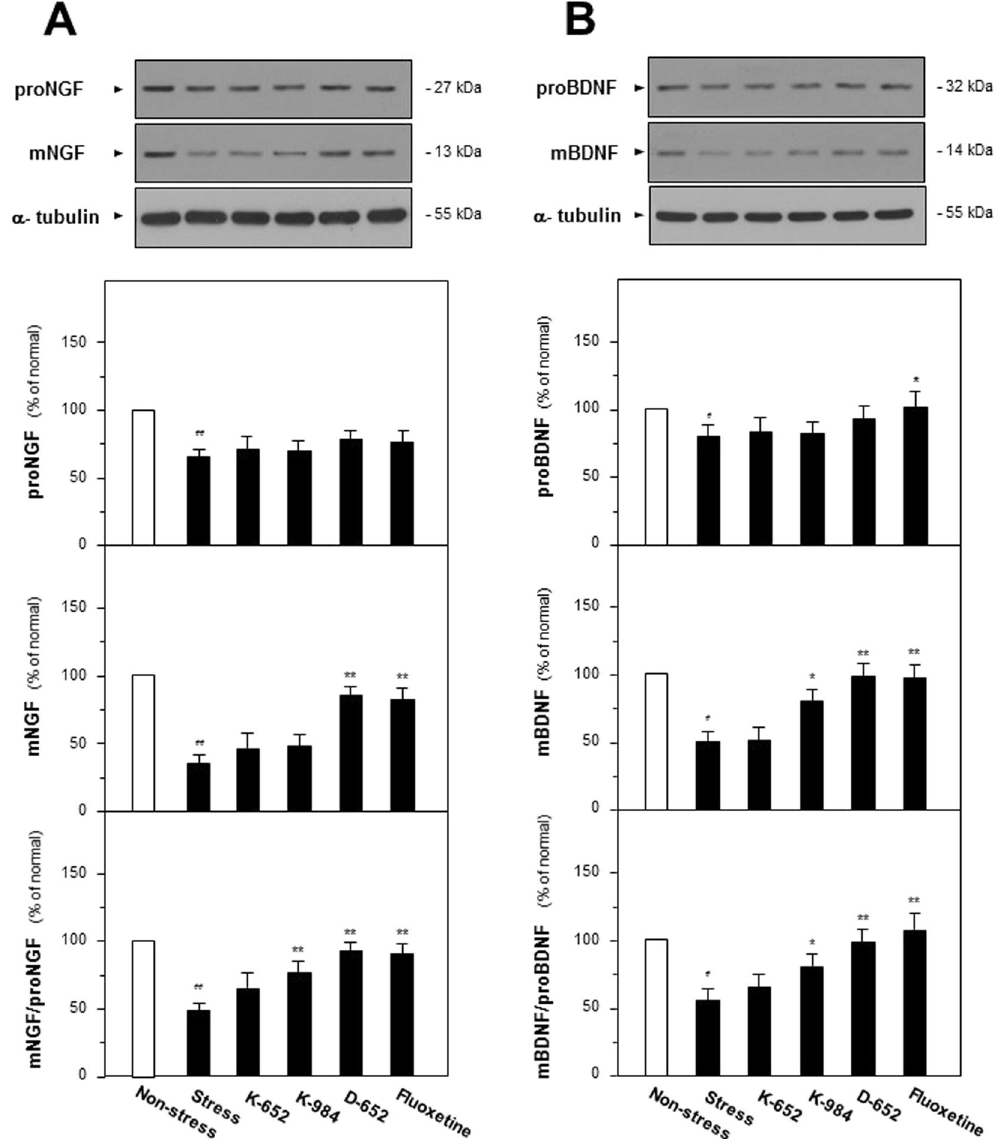
Figure 4. Effect of KXS series formulae treatment on the protein expressions of neurotrophic factors and its precursors in hippocampus of CUMS-treated mice by western analysis. ( A ) The treatment of KXS series formulae and fluoxetine in the mice were same as that in Fig. 1. The hippocampus tissues were collected after four-week treatment and the expressions of proNGF and NGF were analyzed by western blot analysis. α -tubulin was used as the loading control. Afterwards, the ratio of mNGF to proNGF was calculated. ( B ) Expressions of proBDNF and BDNF were determined and the ratio of BDNF to proBDNF was calculated as same as that of NGF. Comparisons between groups were carried out by a one-way ANOVA followed by a post-hoc Bonferroni test. Values are expressed in the percentage of non-stressed group as Mean ± SEM (n = 8). # p < 0.05, ## p < 0.01 (compared with non-stressed group); * p < 0.05, ** p < 0.01 (compared with stressed